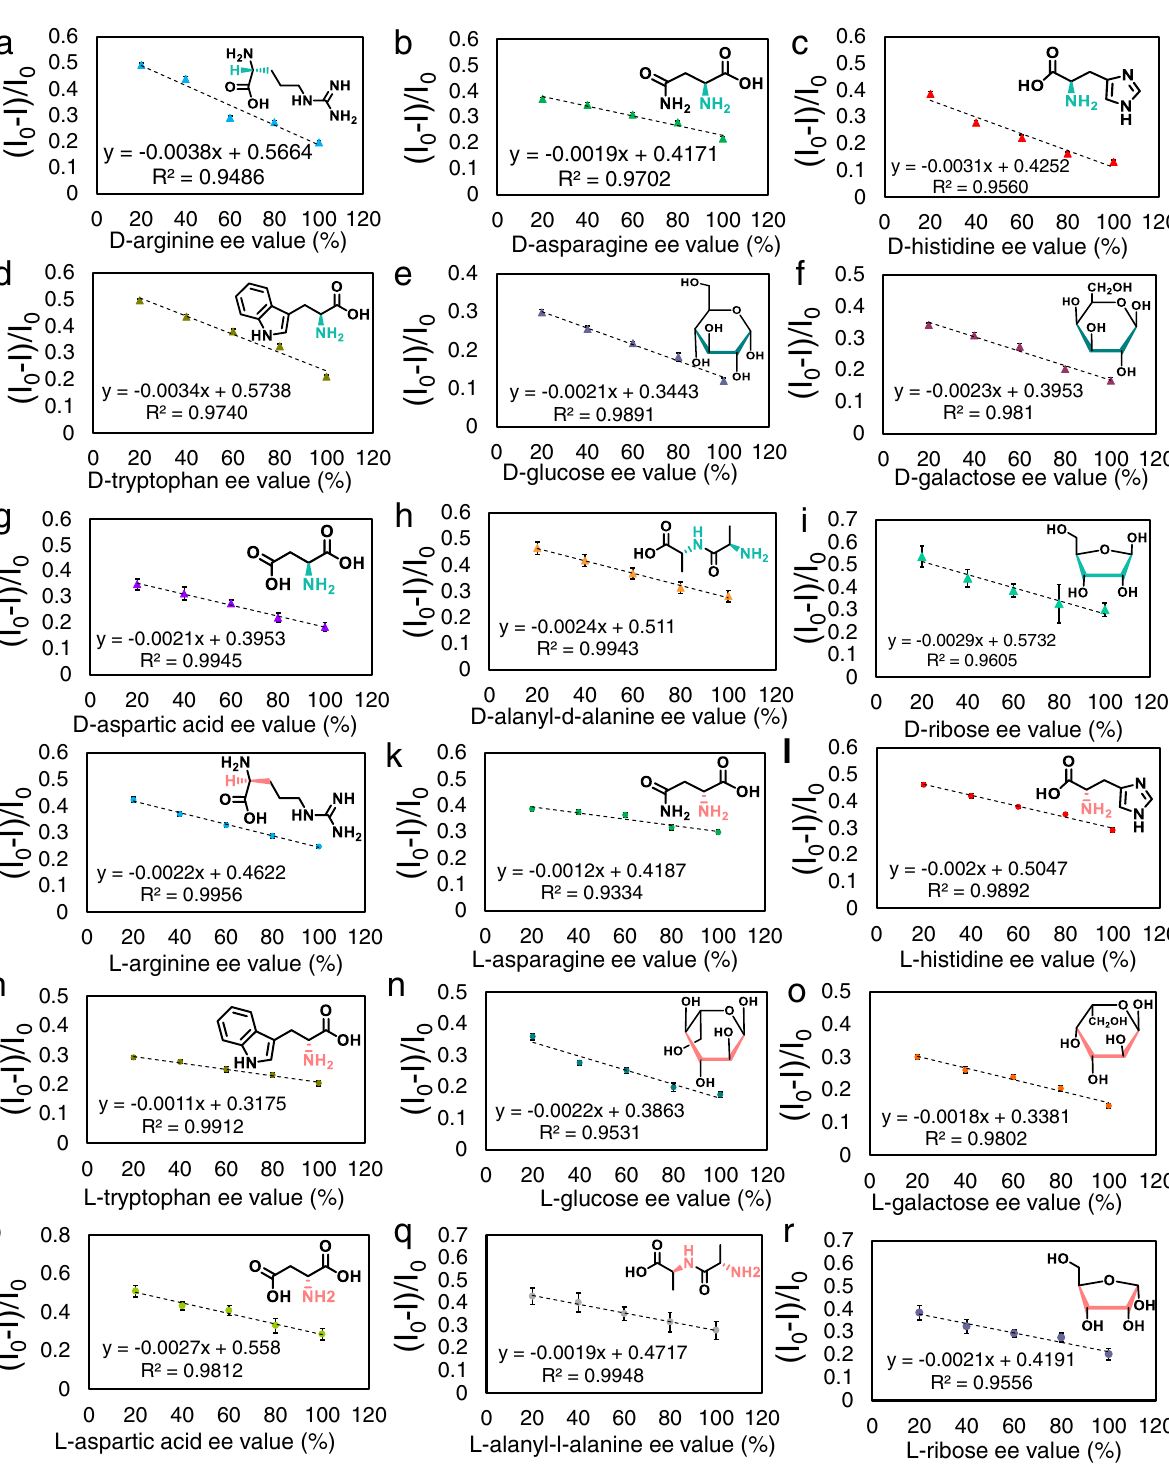
SERS intensities of DTTC before and after IRM, respectively. Raman signals of fi ve different SERS-CIP, whichwereconstructed in different batches, wereanalyzed for eachdatapoint.Errorbarsrepresentstandarddeviations.Sourcedataareprovided as a Source Data fi